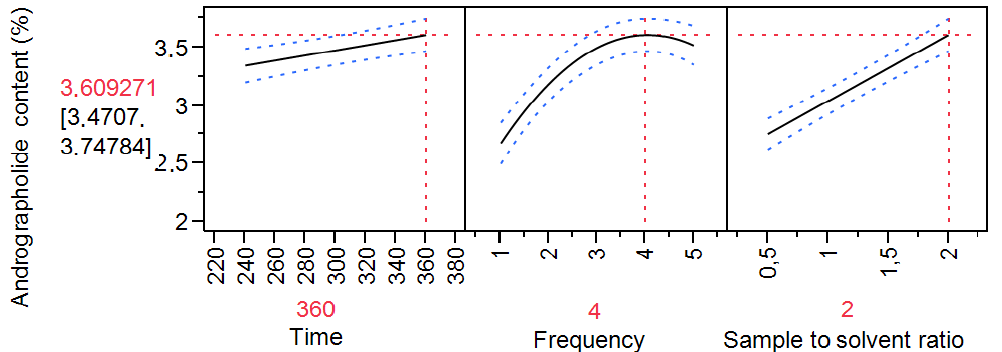
Figure 3. Prediction profile based on regression